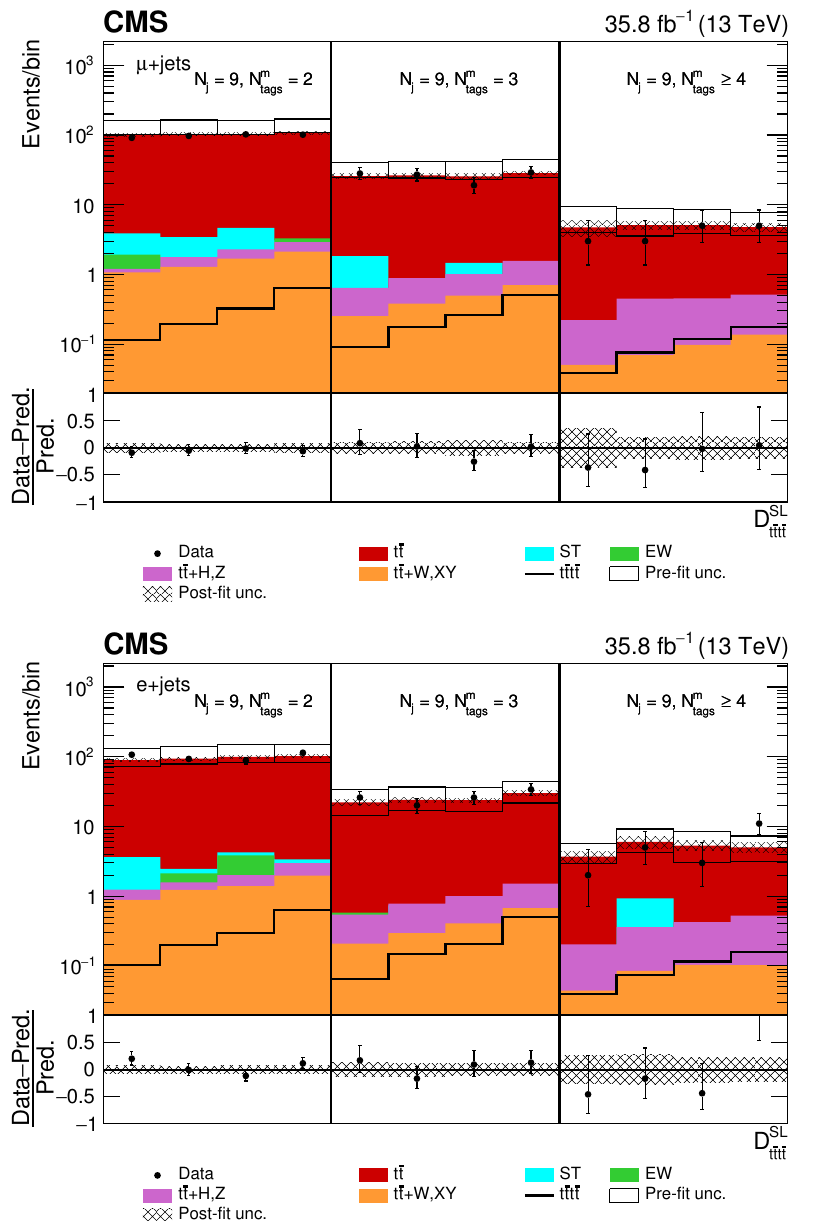
Figure 8 . Post-(cid:12)t D SL distribution in the (upper row) single-muon and (lower row) single- tttt electron channels for events satisfying baseline single-lepton selection and N = 9, N m = 2, 3, j tags (cid:21) 4. Non-uniform binning of the BDT discriminant was chosen to achieve approximately uniform distribution of the tt background. Dots represent data. Vertical error bars show the statistical uncertainties in data. The post-(cid:12)t background predictions are shown as shaded histograms. Open boxes demonstrate the size of the pre-(cid:12)t uncertainty in the total background and are centered around the pre-(cid:12)t expectation value of the prediction. The hatched area shows the size of the post-(cid:12)t uncertainty in the background prediction. The signal histogram template is shown as a solid line. The lower panel shows the relative di(cid:11)erence of the observed number of events over the post-(cid:12)t background prediction.